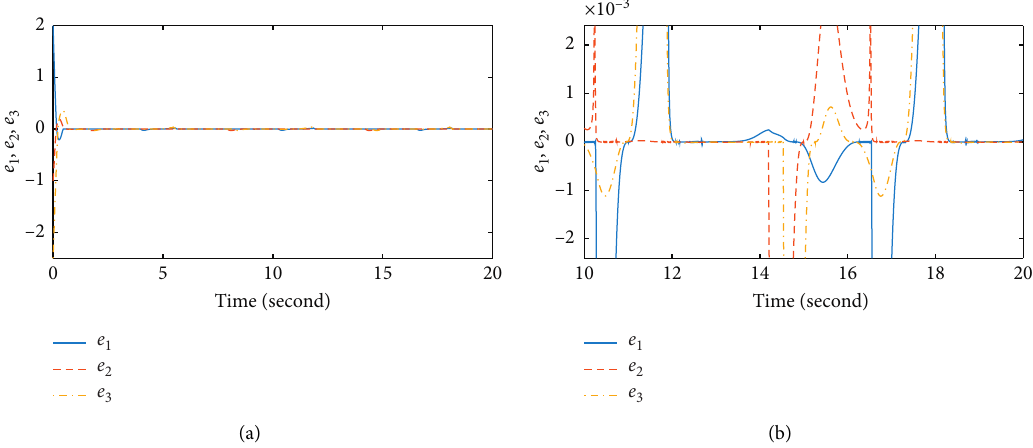
Figure 5: Case 3: the trajectories of tracking error e